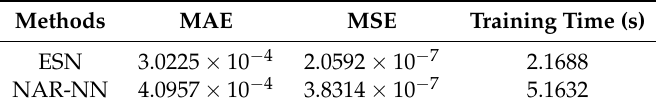
Table 3. Comparison results between ESN and